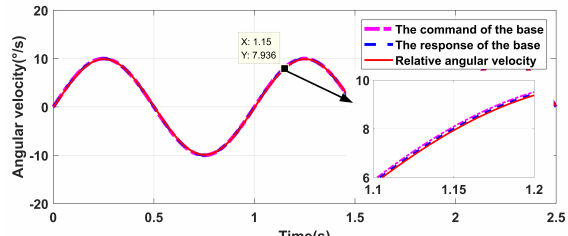
Figure 4. Results of the numerical analysis used in the composite controller.